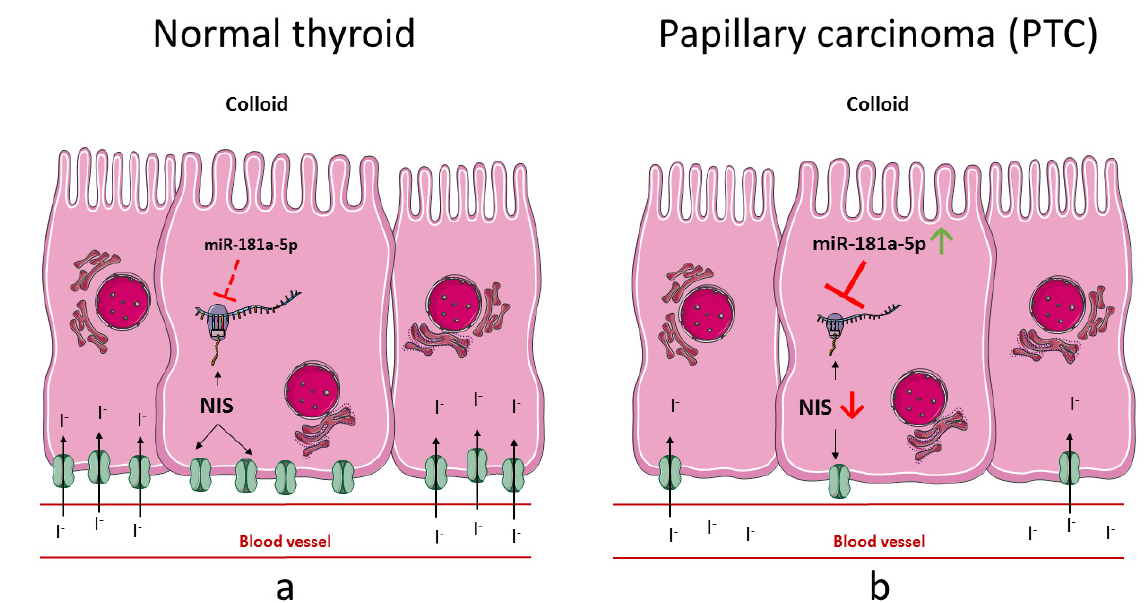
Figure 7. Graphical summary of the study. MicroRNA miR-181a-5p regulates NIS, ( a ) leading to fine-tuning of NIS in normal thyroid tissue, and ( b ) contributing to severe NIS downregulation in the context of PTC. Figure contains elements available at Servier Medical Art repository, licensed under a Creative Commons Attribution 3.0 Unported License. http://smart.servier.com/ accessed 28 March 2021.